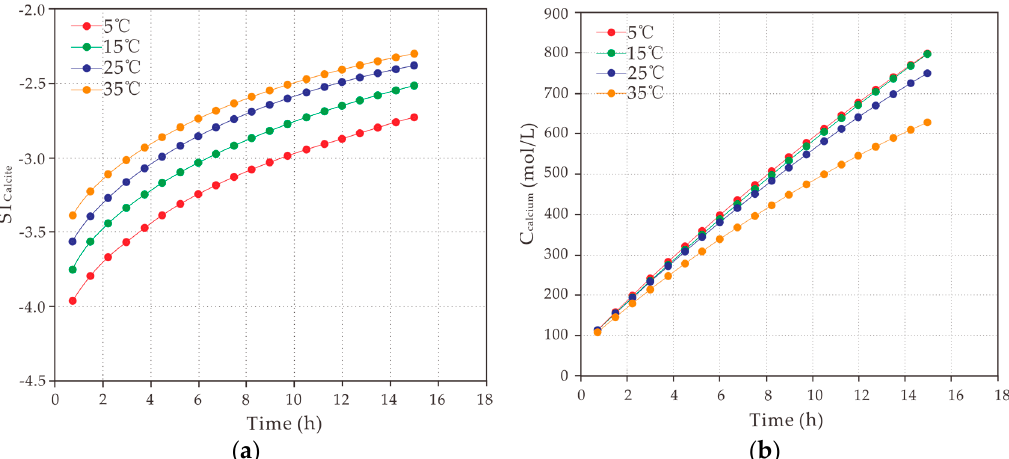
Figure 10. Saturation indexes (SI) for concentration of calcite and calcium at different temperatures: